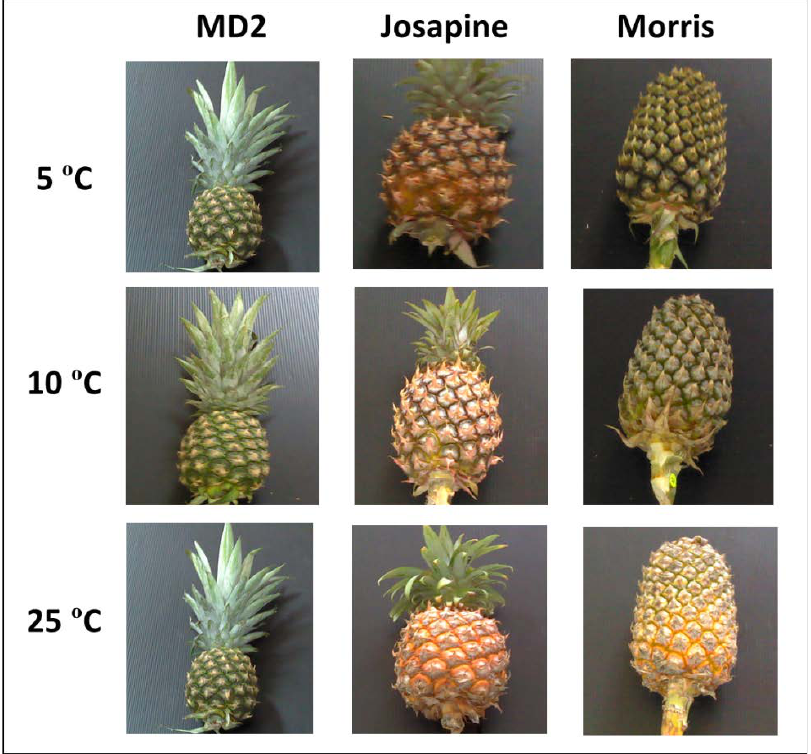
Figure 1. Images of different varieties of pineapples stored at three storage temperatures.